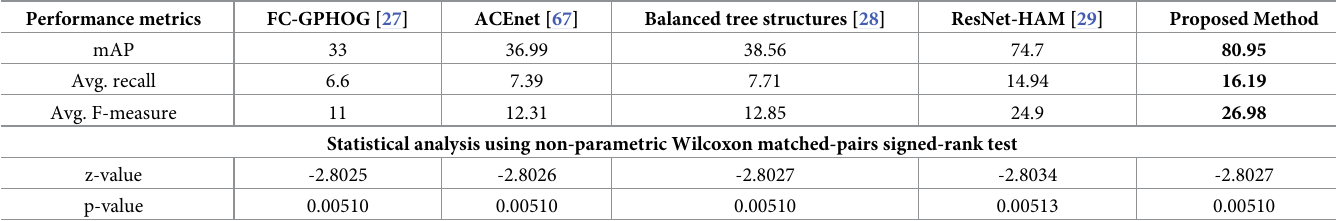
Table 6. Performance comparison of the proposed method with state-of-the-art methods on the Caltech-256 dataset. Performance metrics